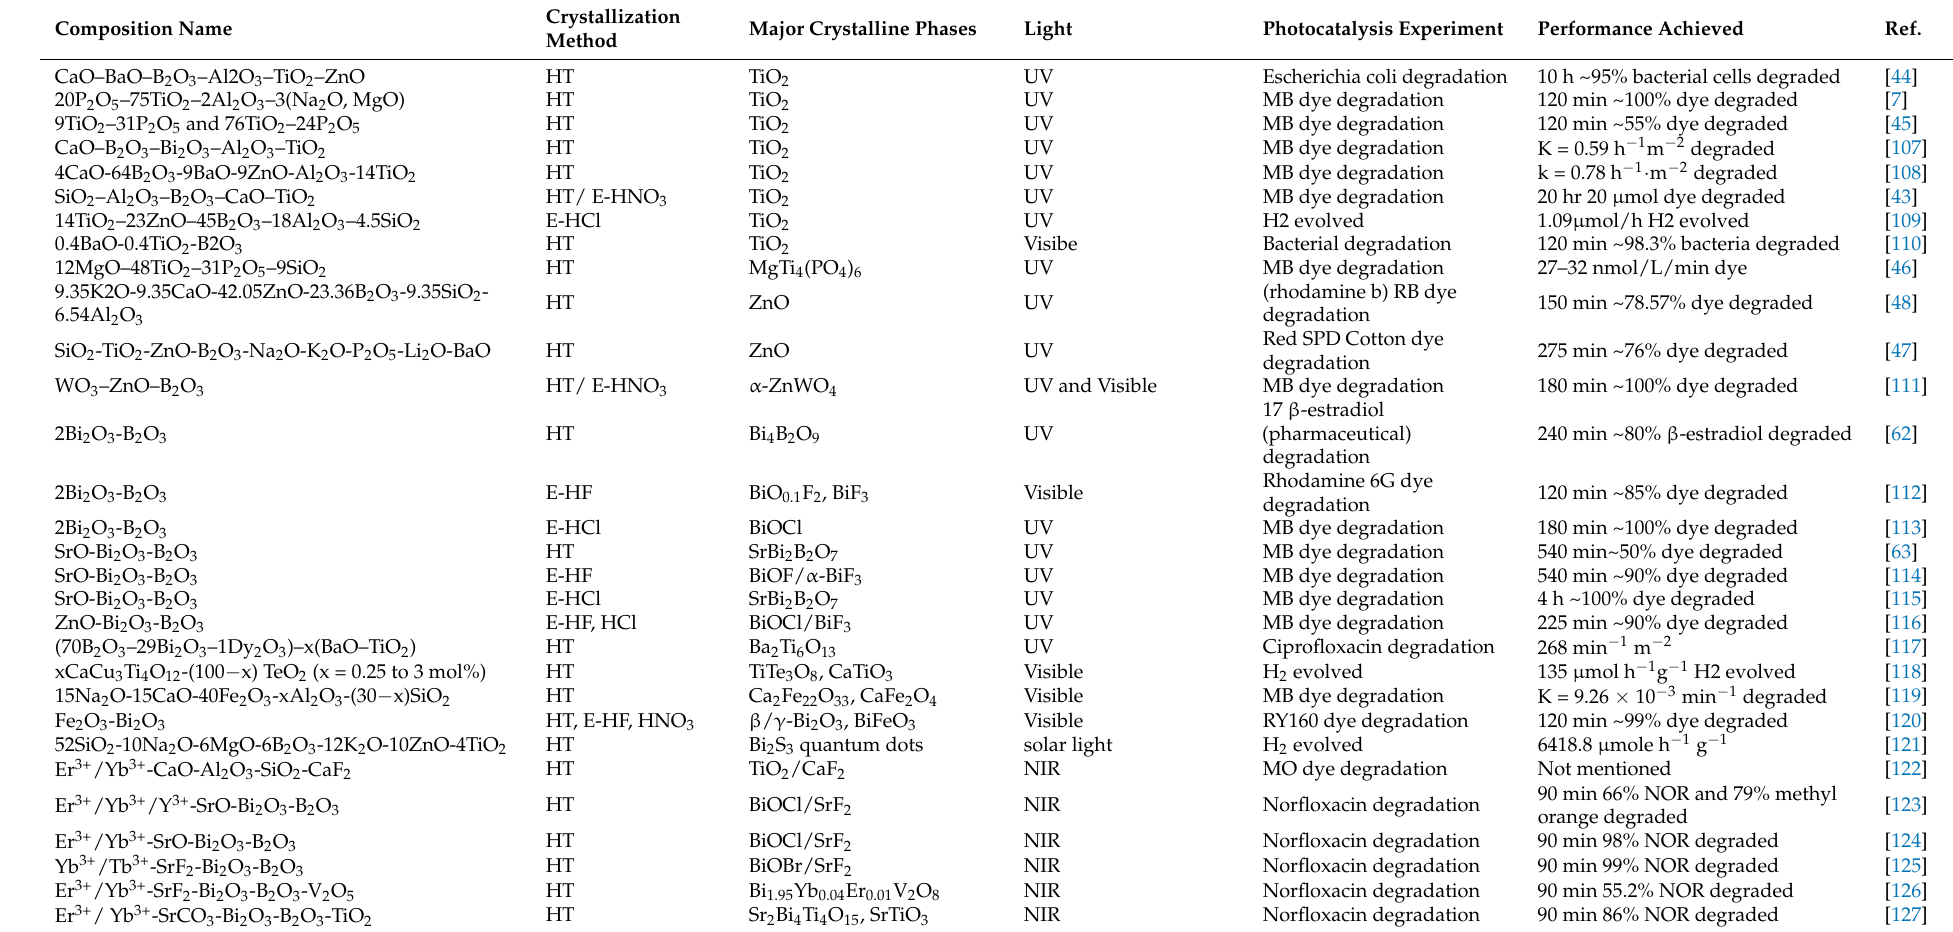
Table 1. Various reported PGCs and their